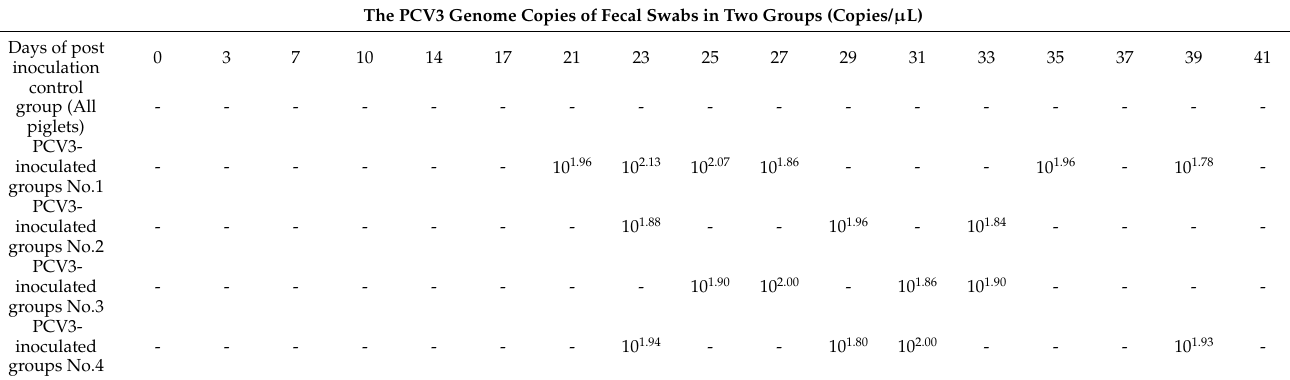
Table 3. Results of PCV3 detection by qRT-PCR in fecal swabs by individual pigs. The PCV3 Genome Copies of Fecal Swabs in Two Groups (Copies/ µ